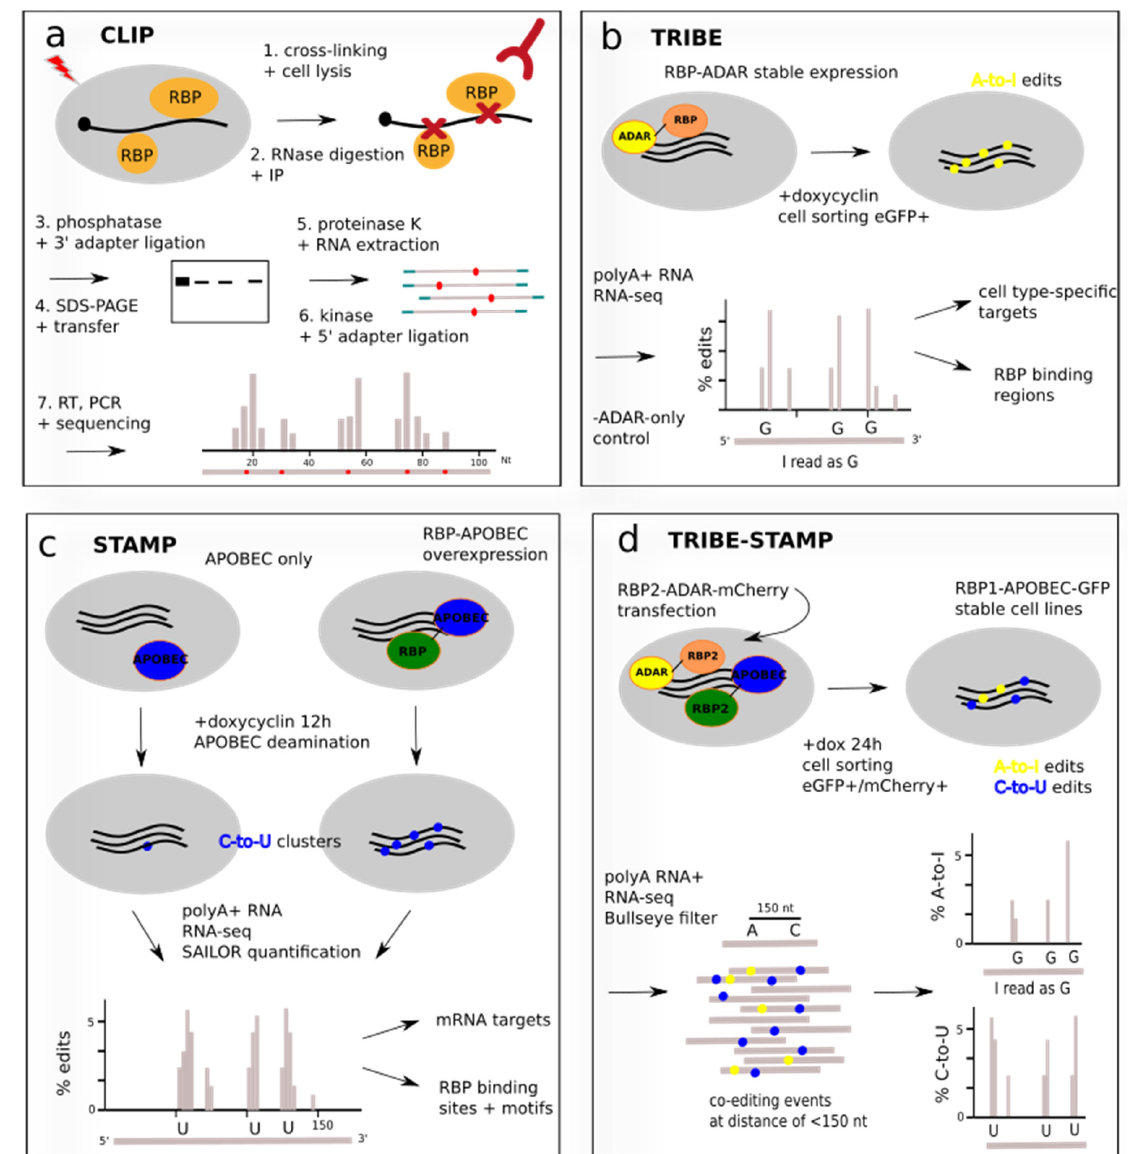
Figure 2. Protein-centric approaches to study RNA–protein interactions. ( a ) Schematic CLIP protocol. UV cross-linked RNA-protein complexes are immunoprecipitated with an RBP-specific antibody, separated by size via gel electrophoresis and transferred to a membrane. Target complexes are excised and RNA is extracted by proteinase K digestion of protein components. A cDNA library protocol is followed and transcripts and RBP binding sites are identified by next-generation sequencing. Note that the order of steps 3. to 7. varies depending on the CLIP protocol. ( b ) TRIBE uses a fusion of the deaminase ADAR and the RBP to induce in-cell A-to-I editing near RBP binding sites. Inducible expression in distinct cell types allows identification of cell-type-specific targets and of binding regions such as 3 ′ UTR or coding sequence. ( c ) STAMP detects RBP binding sites by induced mutations in RNA-sequencing reads. A fusion of deaminase APOBEC to the RBP of interest is overexpressed as stable cell line, and C-to-U conversions are inserted in the RNA in the vicinity of the RBP binding site. Subtraction of background edits yields the editing clusters on target mRNAs. ( d ) Combination of STAMP and TRIBE using a first RBP (RBP1) fused to APOBEC and a transfected second RBP (RBP2) fused to ADAR. Fluorescent cell sorting guarantees parallel expression. cDNA-sequencing maps co-edited sites on the same read and identifies shared RNA targets of RBP1 and RBP2. Editing percentage is defined as the number of A-to-I or C-to-U edits at a given site divided by the number of reads at that site.